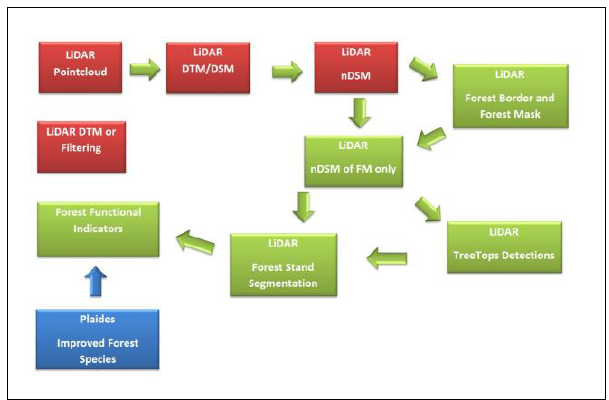
Fig. 5. Workflow of IMPACT Lidar toolbox.